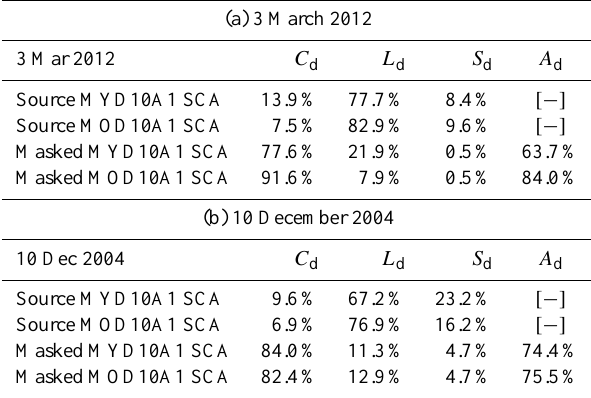
Table 8. Cloud, land and snow percentages ( C d , L d , S d ) in clear- sky maps of 3 March 2012 and 10 December 2004, and percentages after the application of the additional cloud cover ( A d